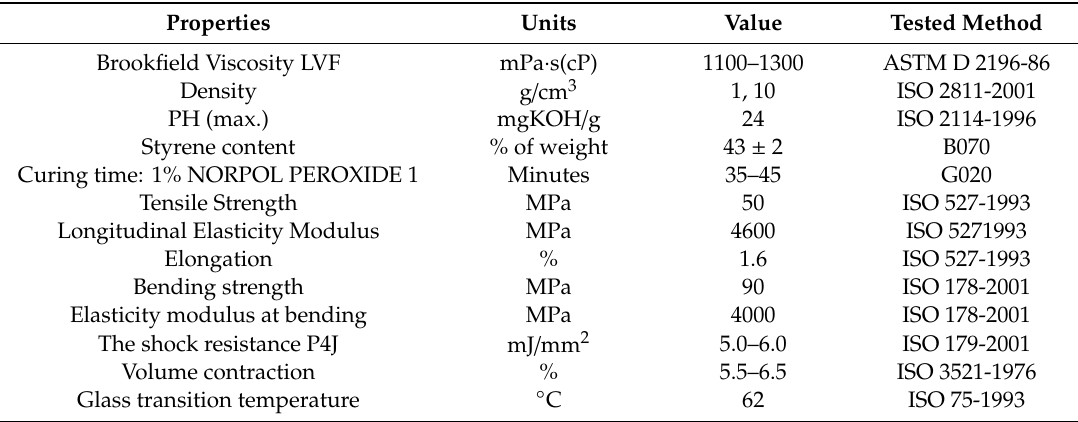
Table 2. The characteristics of the polyester resin type 440-M888 Polylite, at 23 ◦ C.